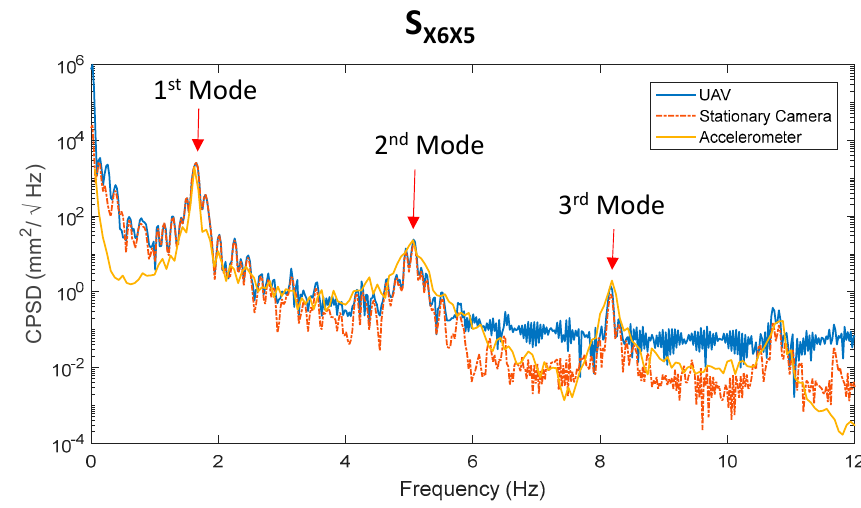
Figure 8. Comparison of cross power spectral density (CPSD) from the unmanned aerial vehicles (UAV) and references.